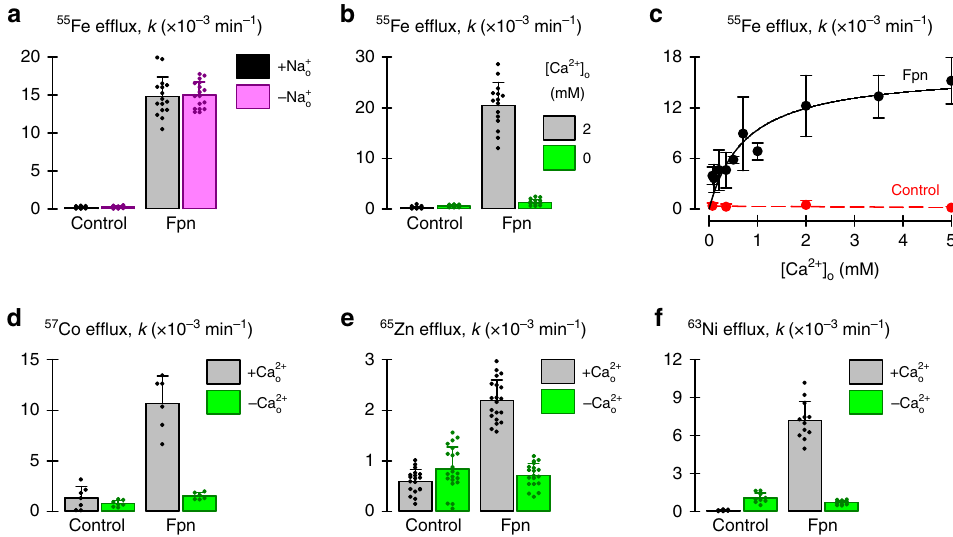
Fig. 1 Calcium activates Fpn-mediated iron ef fl ux in Xenopus oocytes. a First-order rate constants ( k ) for 55 Fe ef fl ux from control oocytes and oocytes expressing human Fpn, in the presence ( + Na + o ) or absence ( − Na + o ) of 100 mM extracellular Na + ; n = 10, 14, 16, 17 oocytes per group (left to right). Two- way ANOVA revealed no interaction ( P = 0.86); within Fpn, + Na + o did not differ from − Na + o ( P = 0.73). b 55 Fe ef fl ux from control oocytes and oocytes expressing human Fpn in the presence of 2 mM extracellular Ca 2 + or in its absence (i.e. 0 mM Ca 2 + plus 1 mM EGTA) ( n = 16, 16, 15, 16). Two-way ANOVA: interaction ( P < 0.001). c 55 Fe ef fl ux from control oocytes (red) and oocytes expressing Fpn (black) as a function of [Ca 2 + ] o (control, n = 30; Fpn, n = 84; i.e. 6 – 9 oocytes per group at each [Ca 2 + ] fi t by Eq. (2): K Ca = 0.8 ± (SEM) 0.2 mM, V k = (16 ± 2) × 10 − 3 min − o ). Fpn data were max occurred at 0 : 5